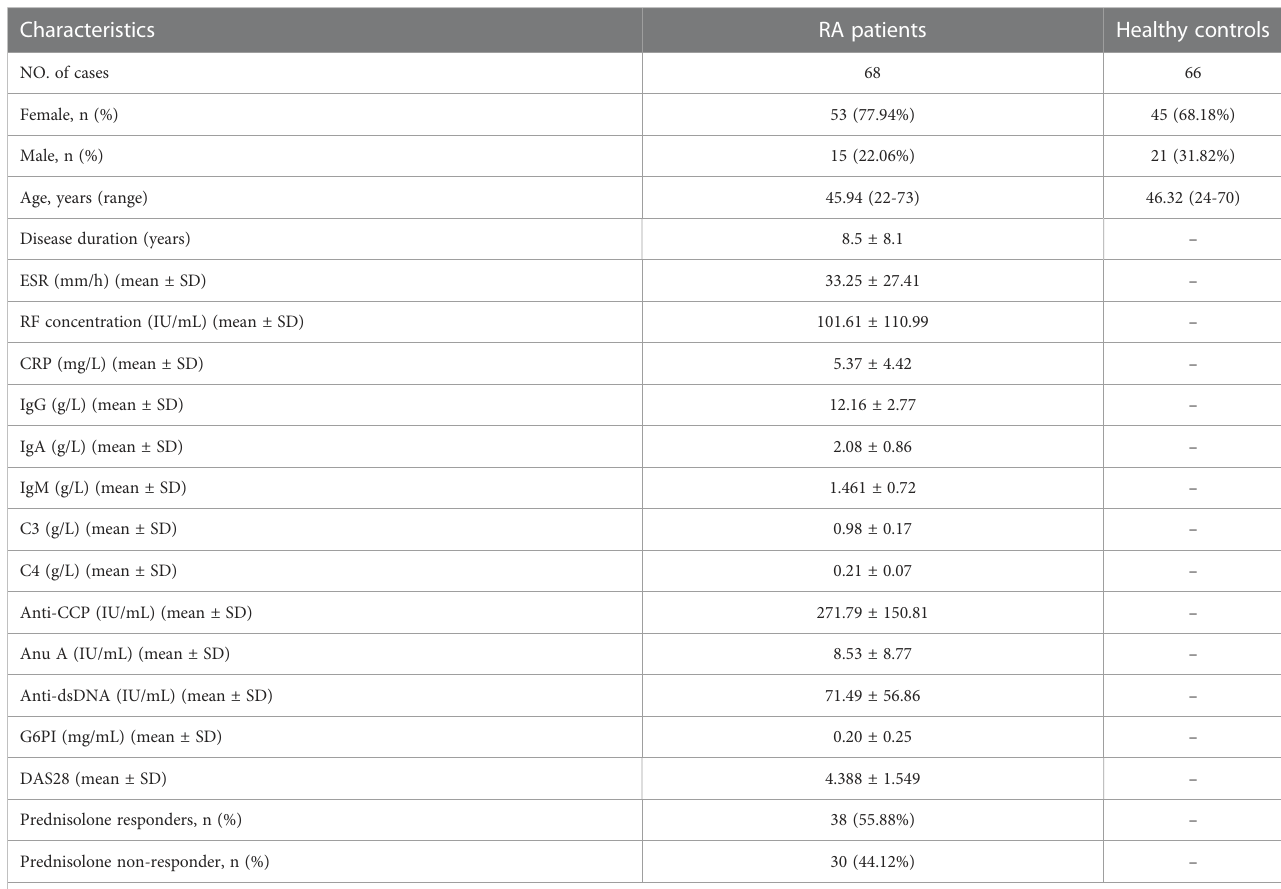
TABLE 1 Demographic and clinical characteristics of